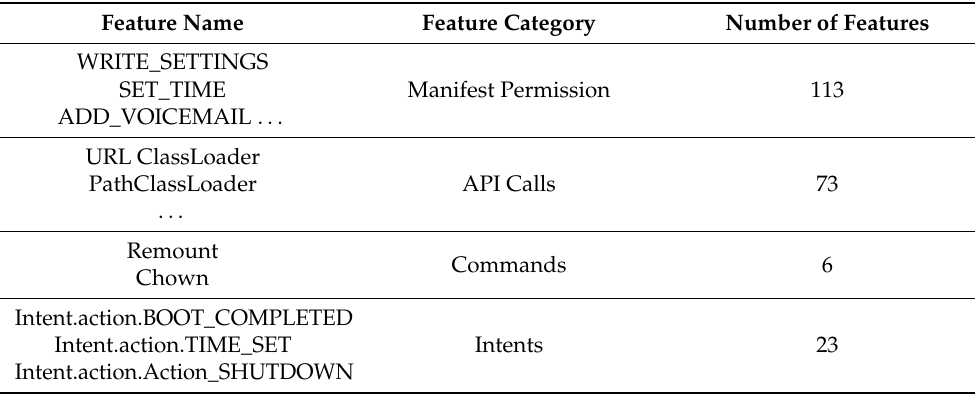
Table 5. Feature details of malware in Malgenome and Drebin